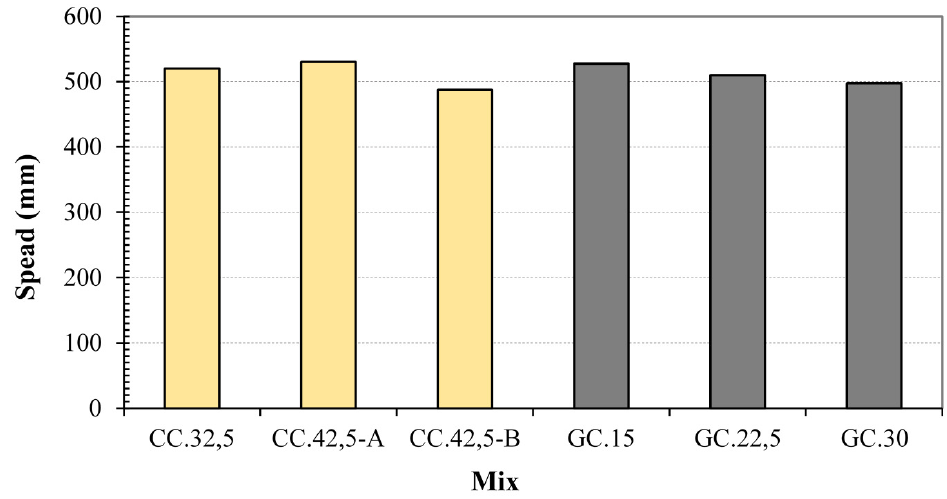
Figure 5. Workability (flow table test) of the mixes.